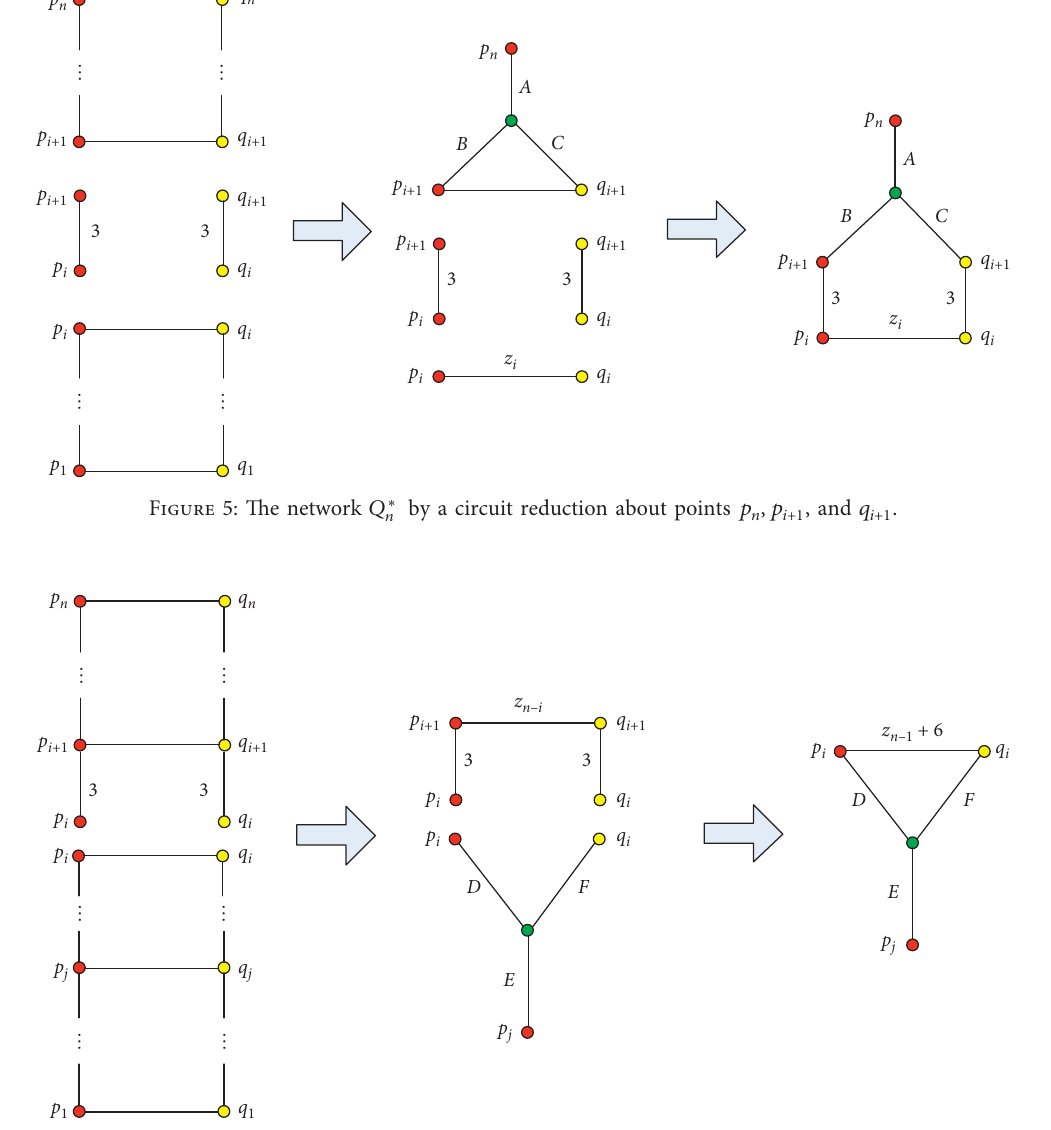
Figure 6: The network Q ∗